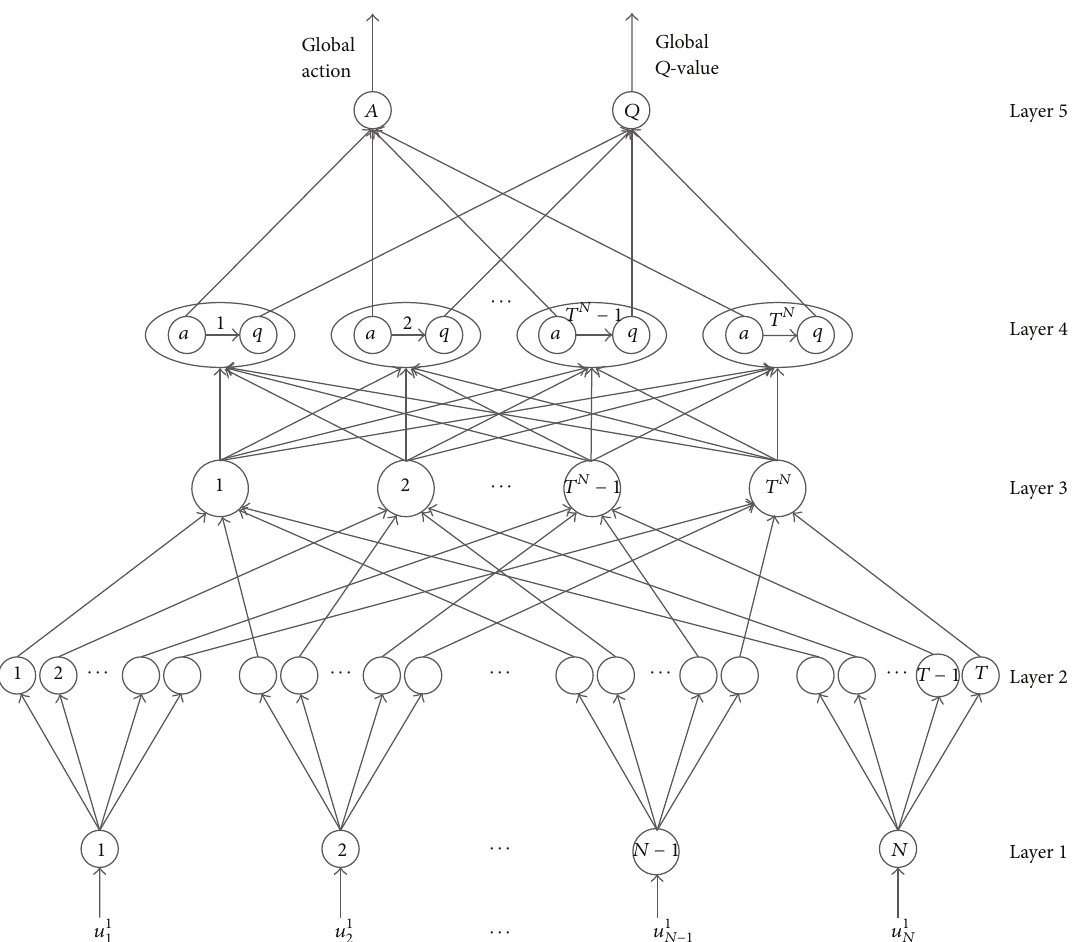
Figure 1: Topology of Q-learning neural fuzzy inference